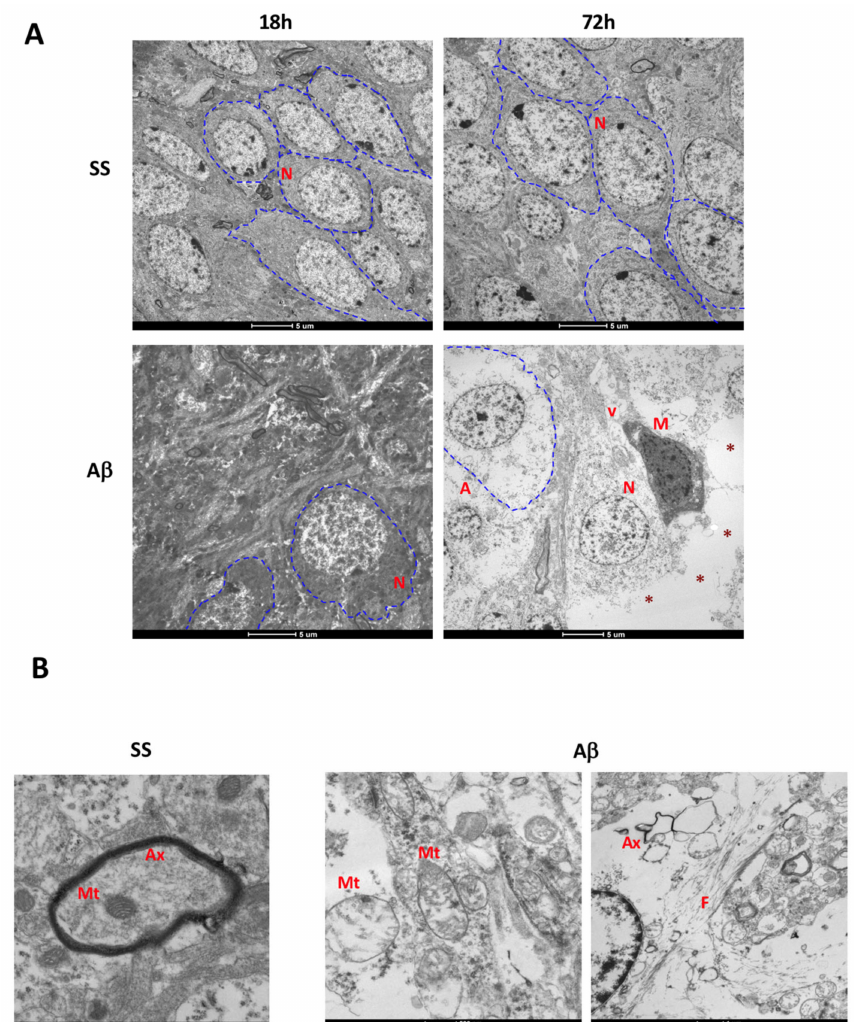
Figure 5. Acute ultrastructural analysis. ( A ) Transmission electron micrographs (Scale bar: 5 µ m) of 18 h and 72 h are shown. Blue dashed lines identify at least one neuron (N) in each image. After 18 h, A β O decreases neuron density. At 72 h, neuronal loss spaces are evident (red asterisks), in addition to swollen astrocytes (A), and the presence of vacuolated microglial cells (M). ( B ) Magnification at 72 h show the presence of swollen mitochondria (Mt), axon (Ax) degeneration, vacuoles in the neuropil, and fibrils (F) in the A β O